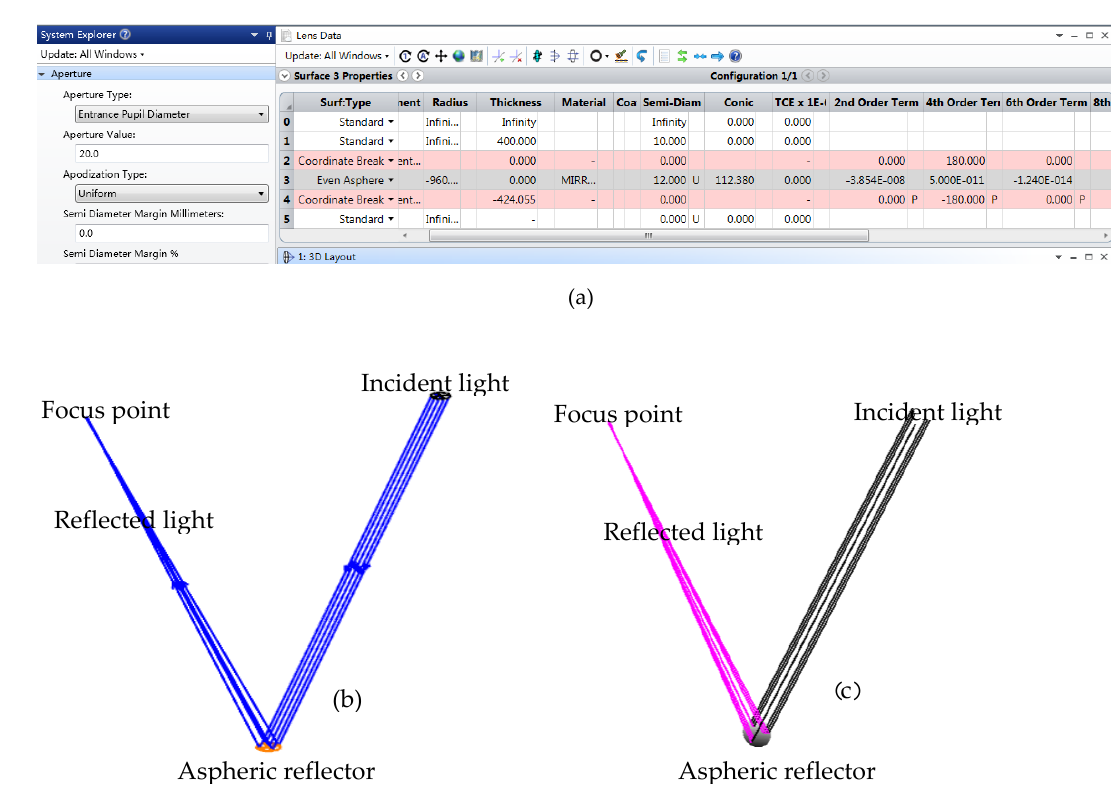
Figure 10. The light paths simulated with Zemax and self-compiled programs. ( a ) The input parameters in the Lens Data Editor of Zemax; ( b ) the ray tracing using the Zemax software; ( c ) the ray tracing using a self-compiled Matlab program.